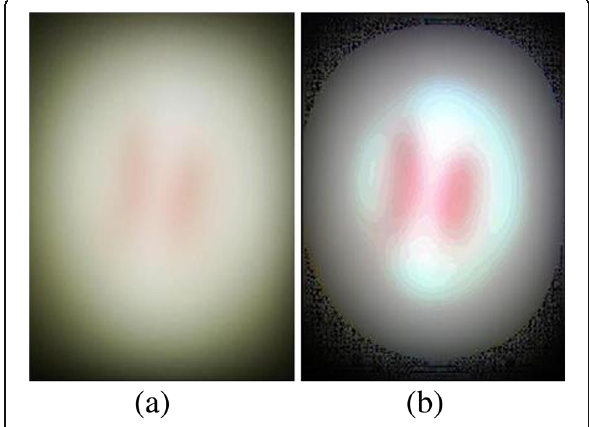
Fig. 7 The original image and the color phantom image finally obtained by the preprocessing algorithm. ( a ) is original image, ( b ) is the color phantom image finally obtained by the preprocessing